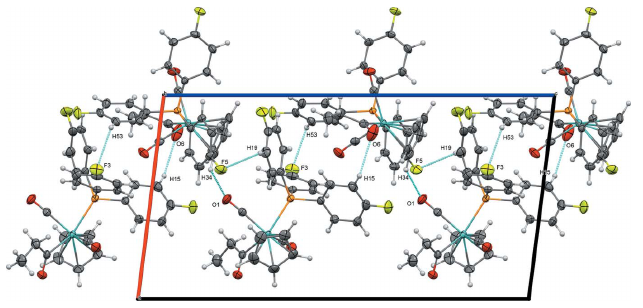
C—H (cid:2) (cid:2) (cid:2) O interactions (2.60 A˚ ) between O1 of the other carbonyl ligand and H6 from a cyclopentadienyl ligand (Fig. 5). The tris(4-fluorophenyl)phosphine-supported derivative ( 2 ) features two nearly equivalent molecules in the asymmetric unit exhibiting a non-classical C—H (cid:2) (cid:2) (cid:2) O interaction between O6 of a propionyl ligand and H15 from a phenyl ring (2.59 A˚ ) and a C—H (cid:2) (cid:2) (cid:2) F close contact between F3 and H53 (2.60 A˚ ). These pairs of molecules are joined into chains along [001] by